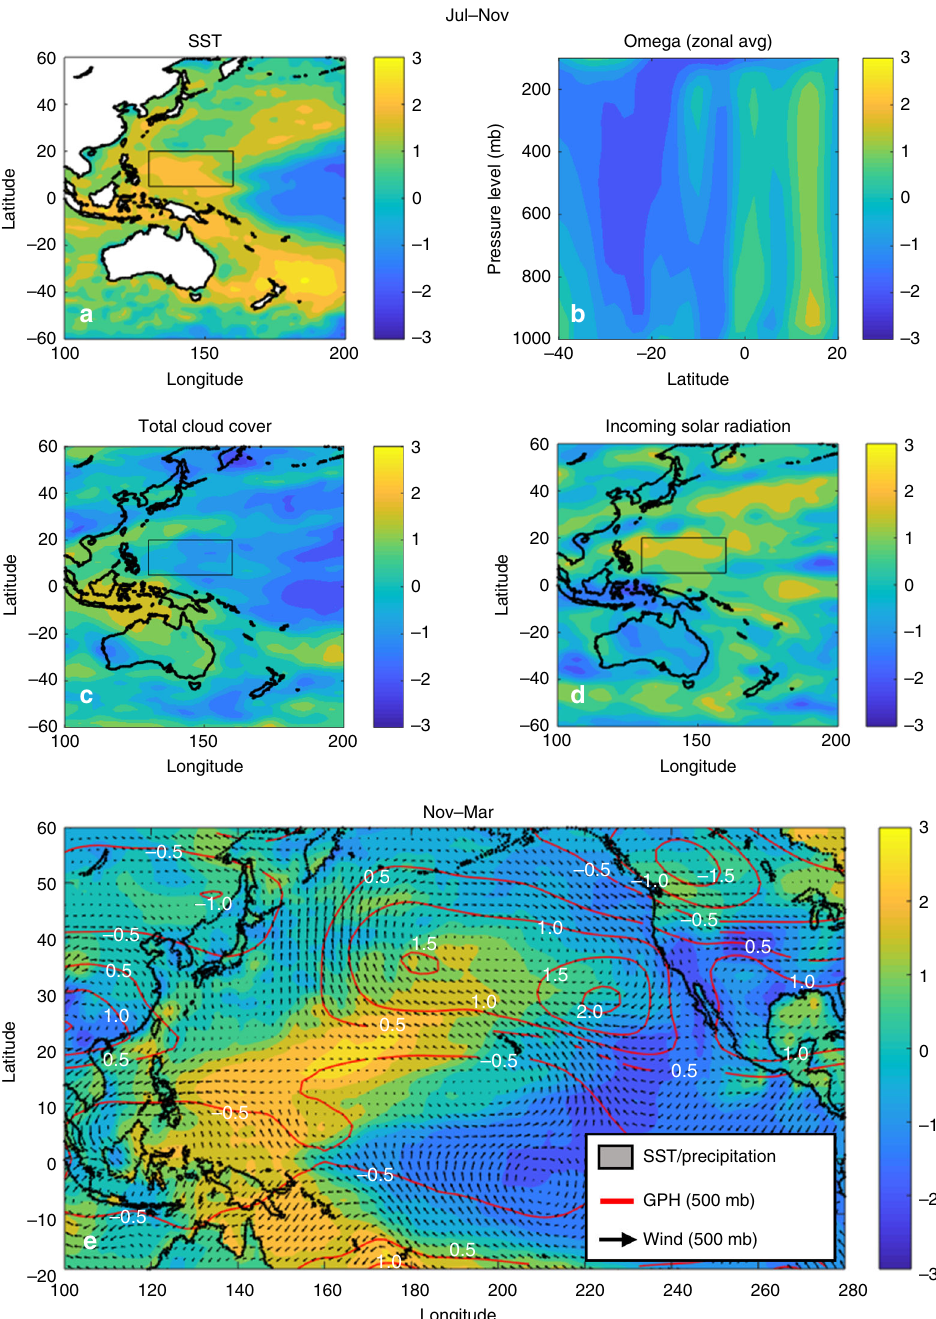
Fig. 3 Composite differences between 5 warmest and 5 coldest NZI years during 1982 – 2015. a Jul – Nov SST, b Jul – Nov zonal average omega velocity over 100°E – 200°E (positive sign corresponds to decreased ascending motion), c Jul – Nov total cloud cover (TCC), d Jul – Nov incoming solar radiation (ISR) at the surface, and e Nov – Mar SST (shading over ocean), land precipitation (shading over land), geopotential height (GPH; contours) and horizontal wind (vectors) at 500 mb pressure level. All values have been standardized by dividing with the standard deviation of the respective series in 1982-2015. In a , c , d , the EPI box is also shown. As suggested in M18, results support that warm NZI is associated with decreased convective activity and cloud cover,